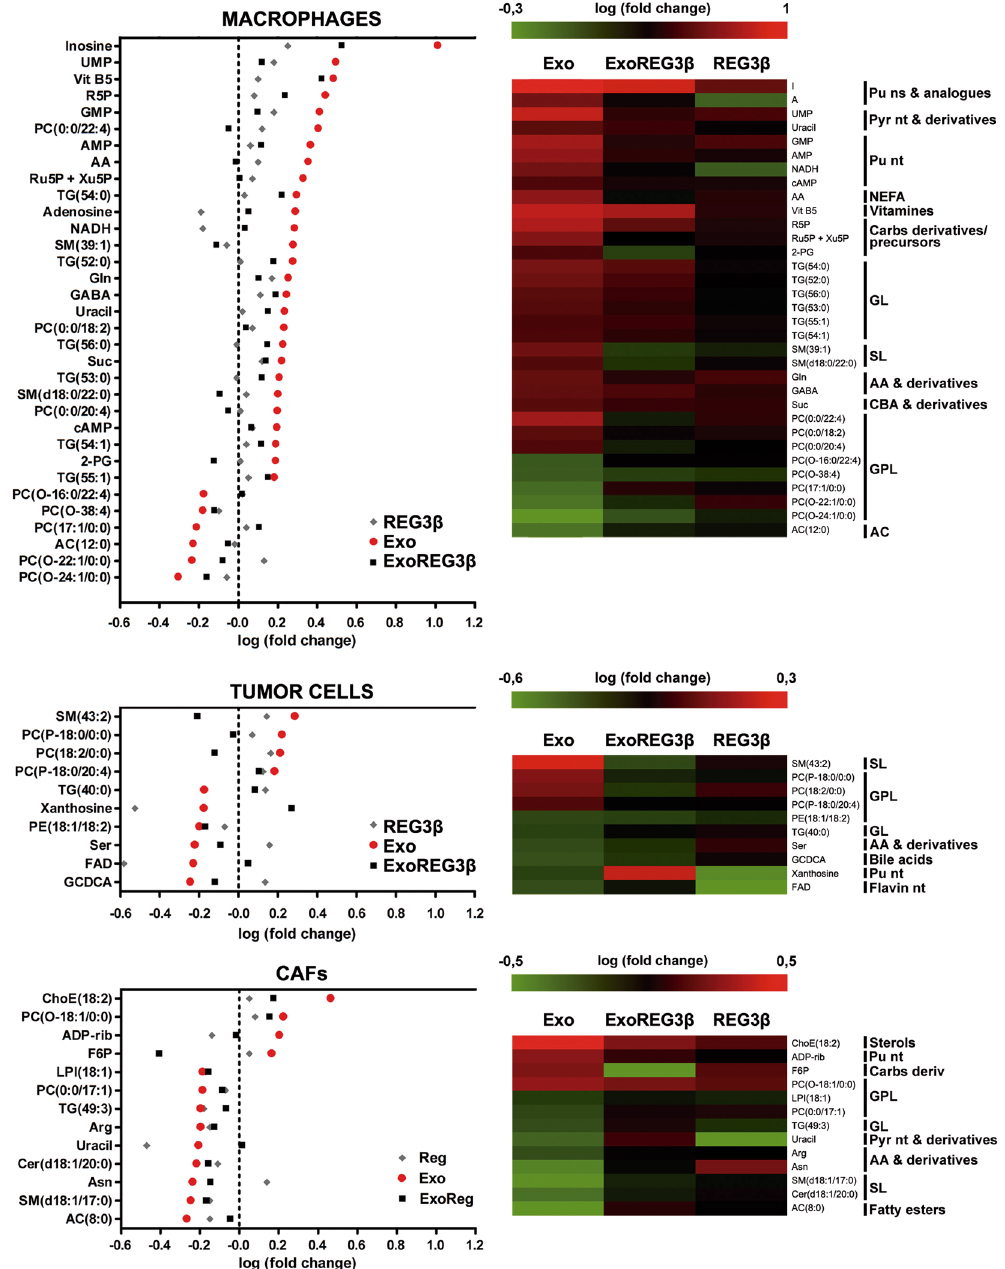
Figure 4. Impaired metabolic switch in the three main cell types of tumor microenvironment due to EV blockage by REG3 β . Metabolomic analysis of those metabolites which the REG3 β -blocking of signal transduction through EVs prevented increases or decreases in their dysregulation. Heatmaps of metabolites grouped according to their chemical class in order to illustrate the most frequent altered families by this blocking mechanism. AA (aminoacids), AC (acylcarnitines), Carbs (carbohydrates), CBA (carboxylic acids), GL (glycerolipids), GPL (glycerophospholipids), NEFA (non-esterified fatty acids), ns (nucleosides), nt (nucleotides), Pu (purines), Pyr (pyrimidines), SL